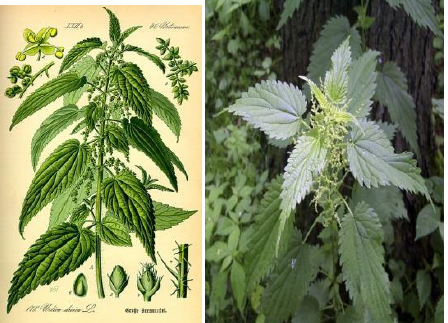
Figure 1. Various parts of nettle (Debnath, 2015)